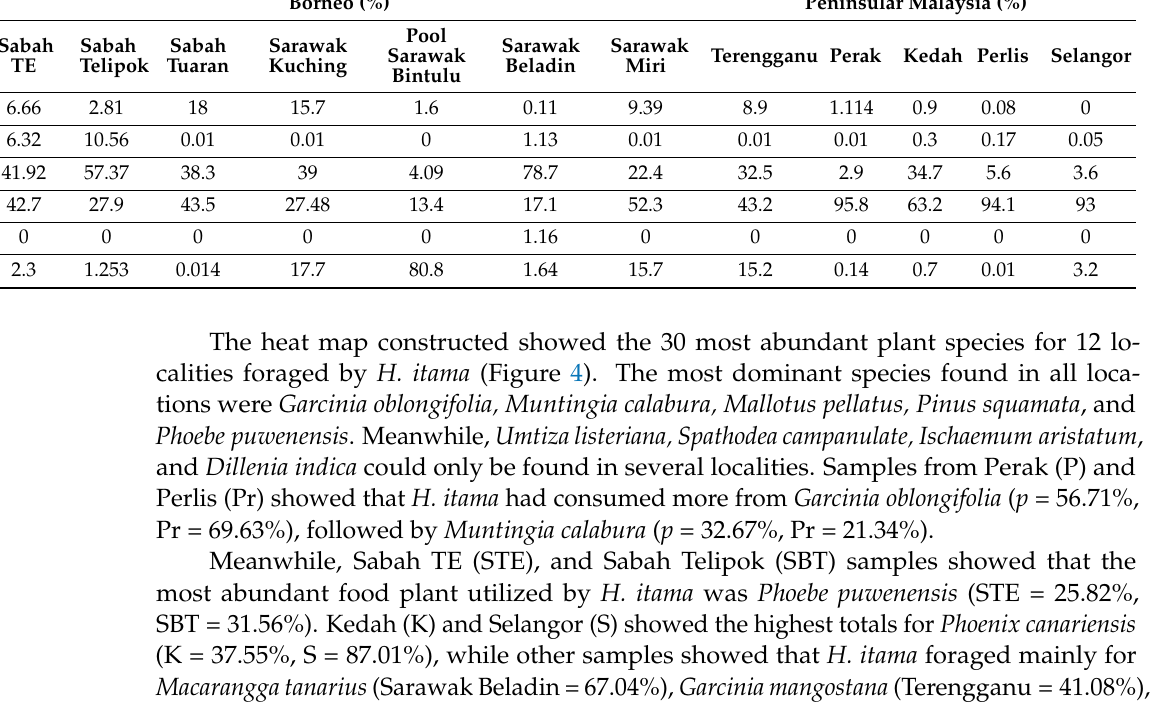
Table 4. Relative abundance at the phylum level of plant communities in Heterotrigona itama from different localities. Borneo (%) Peninsular Malaysia (%) Phylum Sabah